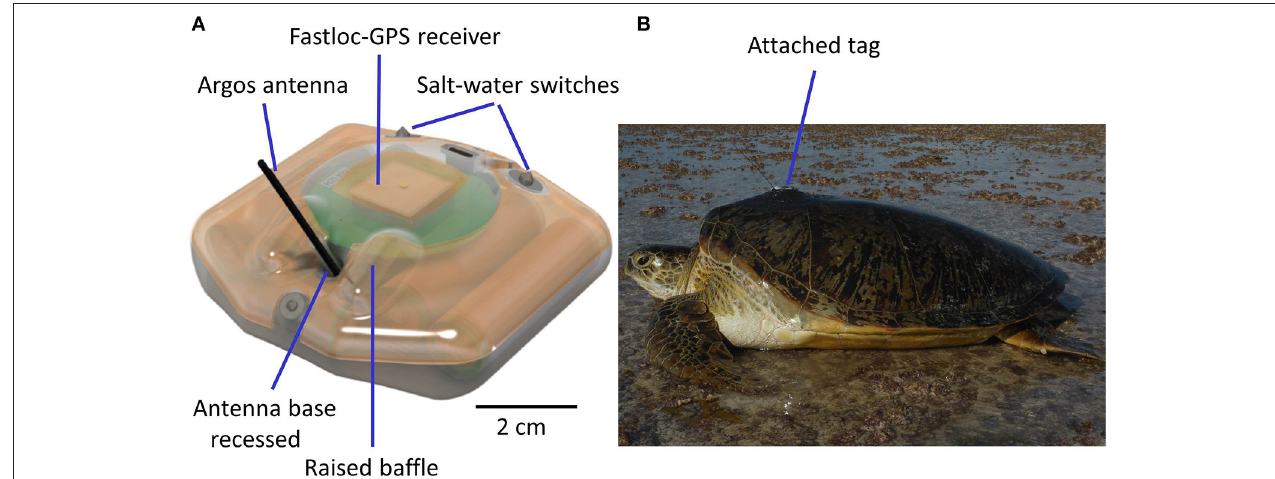
FIGURE 2 | Secure attachment of robust, low profile Argos tags providing minimum drag is now routine (A). A schematic of a Fastloc-GPS Argos SPLASH manufactured by Wildlife Computers. Features of the tag which help prevent any damage if the turtle scrapes against rocks include the low profile of the tag, the flexible Argos antenna and the base of the antenna being in a depression protected by raised baffles. These features help reduce the likelihood of direct impacts to the base of the antenna and with any impacts the antenna simply bends rather than snaps (B). A photograph of the tag featured in (A) attached to a green turtle that had completed nesting (photo Graeme Hays). Note the low profile. The attachment has been painted with anti-fouling paint. For use of this tag see, for example, Hays et al. (2014b), Esteban et al. (2017), Thomson et al. (2017) and Christiansen et al. (2017). For a video of attachment see Supplementary Information .